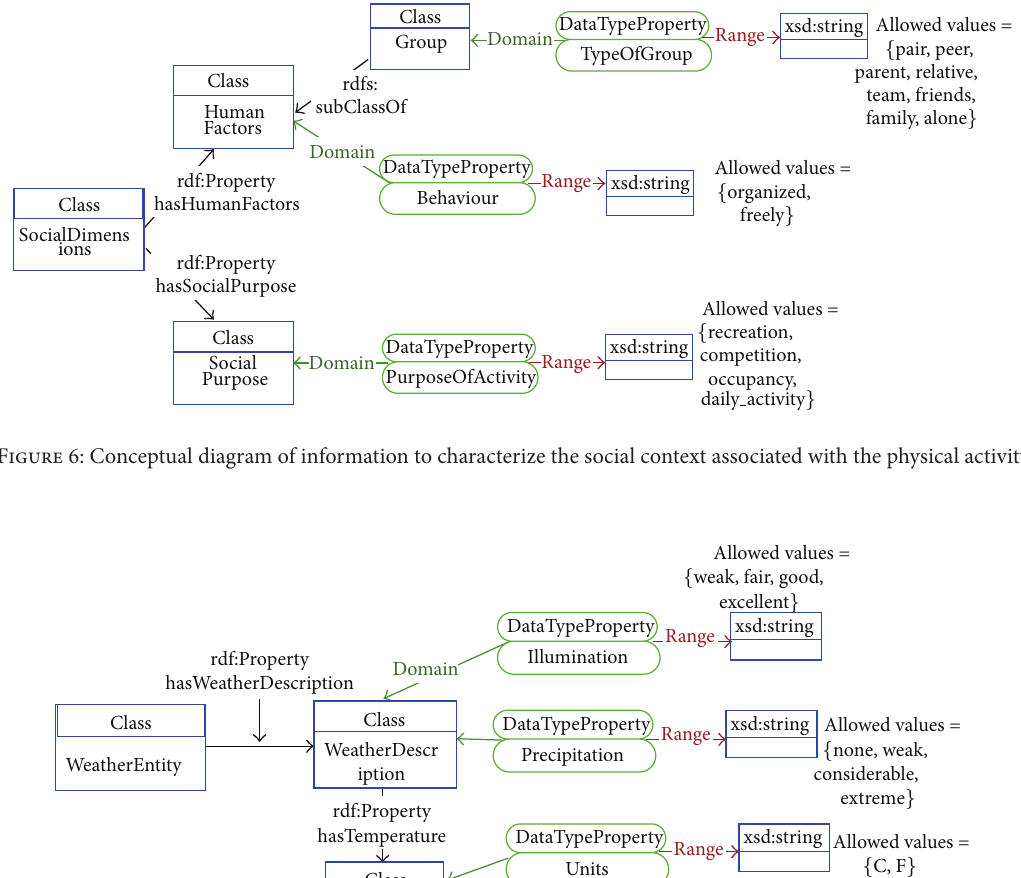
provide all the concepts required to obtain a detailed char- acterization of people, their physical activity, and associated